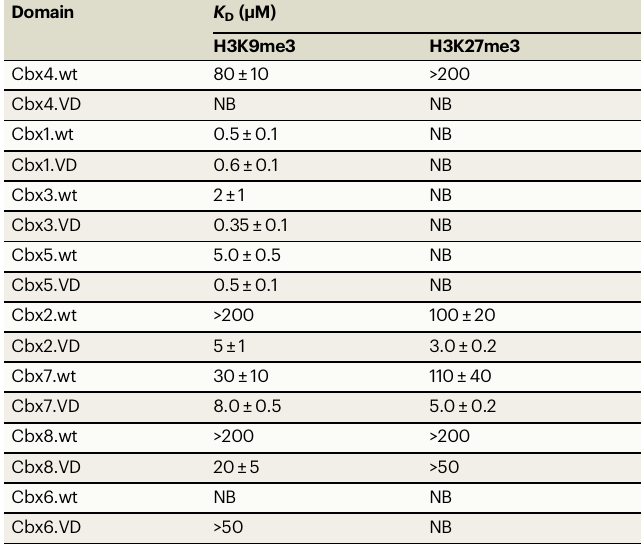
Table 3 | Dissociation constants for Cbx.wt and Cbx.VD pairs for methyllysine-containing peptides